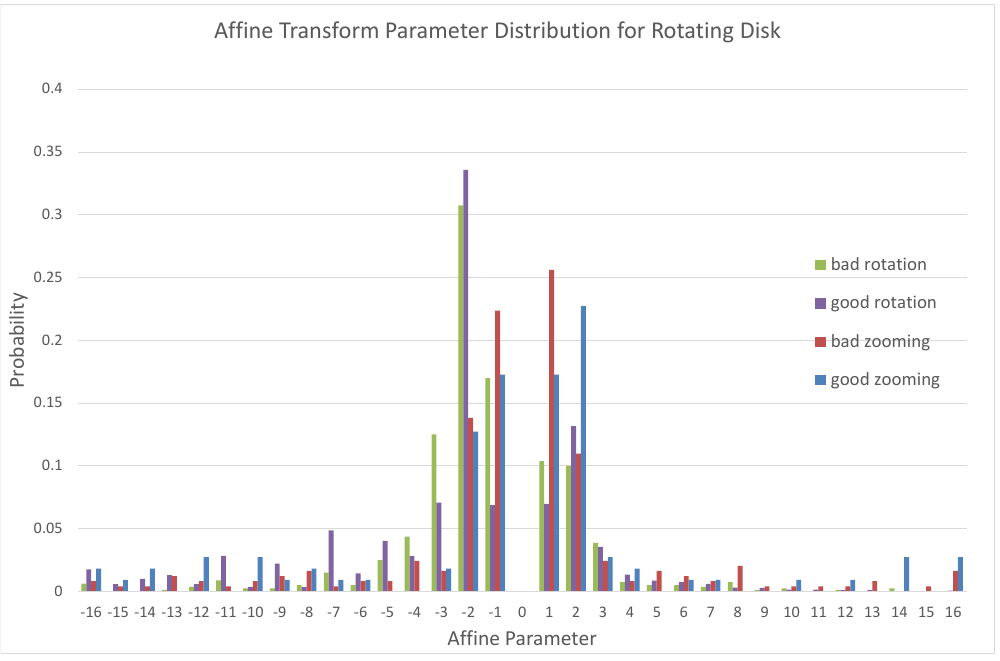
Figure 1. Distribution of the affine parameter (quantization levels) in the Rotating Disk sequence for accurately and incorrectly predicted transform